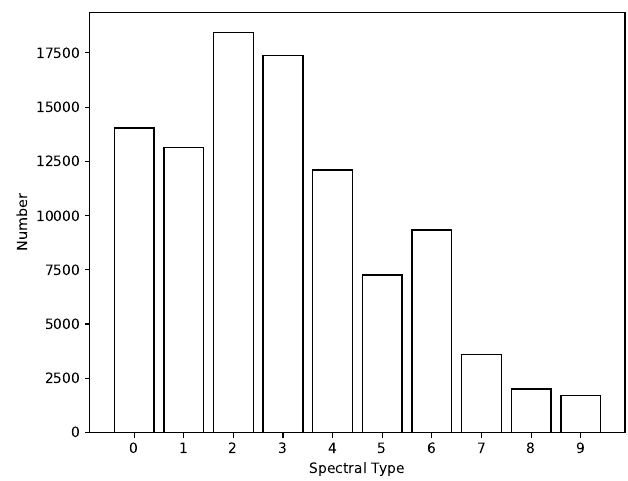
Figure 5. Spectral type and distribution of M stars of SDSS.